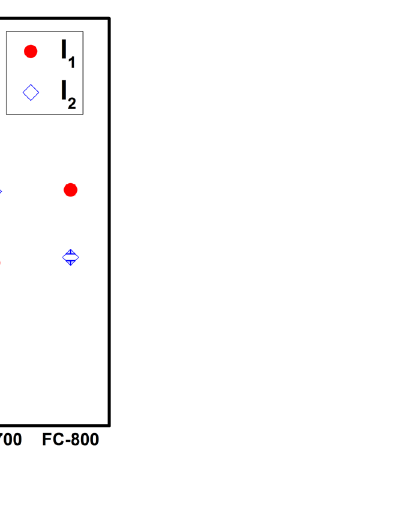
Figure 8. Lifetime Intensities for different